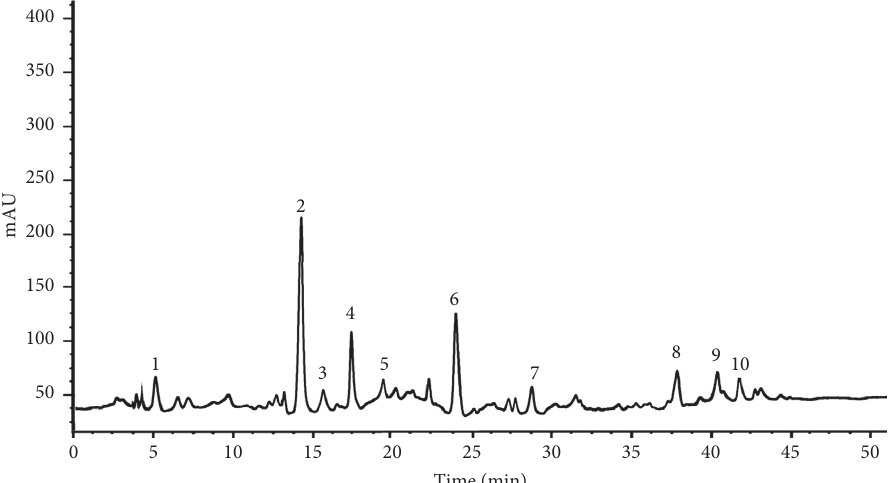
Figure 1: HPLC-DAD chromatograms of the parsley extract. Peak numbers: gallic acid (1); chlorogenic acid (2); vanillic acid (3); caffeic acid (4); syringic acid (5); p-coumaric acid (6); ferulic acid (7); rutin (8); luteolin (9); and quercetin (10). Table 1: Phenolic and flavonoid profile determined by HPLC in the three Apiaceae species extracts (mg/100 g DW). Celery Coriander